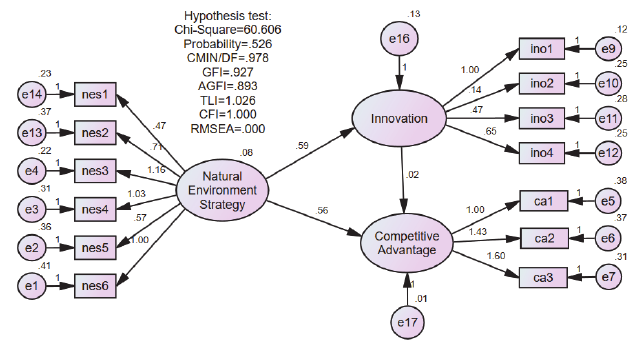
Fig. 1. The Natural Environment Strategy, Innovation and Competitive Advantage theoretical model (created by AMOS Graphics v.